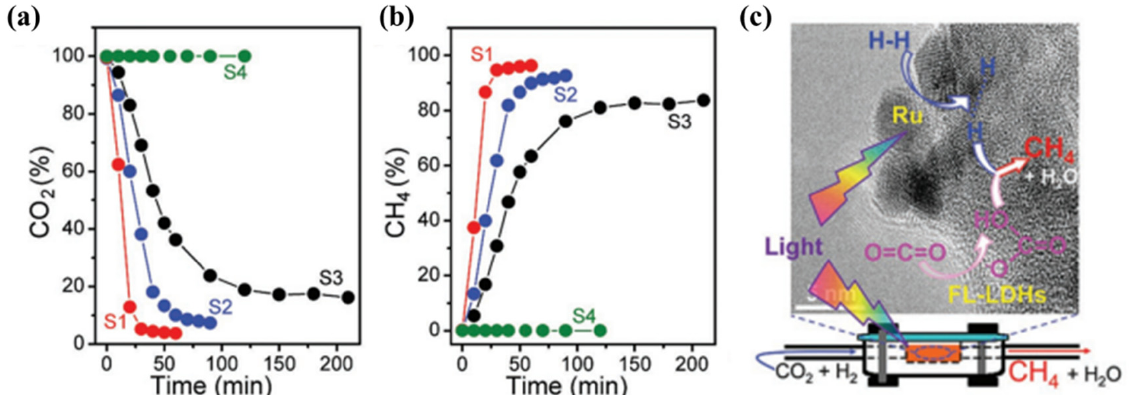
Figure 8. Concentration change of ( a ) CO 2 reactant and ( b ) CH 4 product in photothermal CO 2 methanation over different catalysts (S1: Ru@FL-LDHs; S2: Ru@LDHs; S3: Ru@SiO 2 ; S4: FL-LDHs). Reaction condition: 150 mg catalysts, H 2 : 20.5 mL · min − 1 , CO 2 : 5.0 mL · min − 1 , 300 W xenon lamp. ( c )